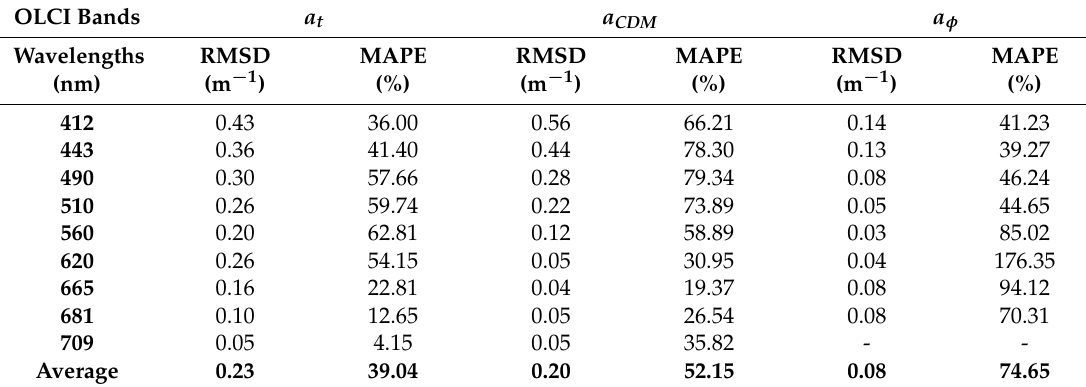
Table 7. Comparative band-specific errors after validation procedure of a t ( λ ) , a CDM ( λ ) , and a φ ( λ ) based on MAPE (%) and RSMD (m − 1 ) metrics. The first column represents the nominal OLCI center bands